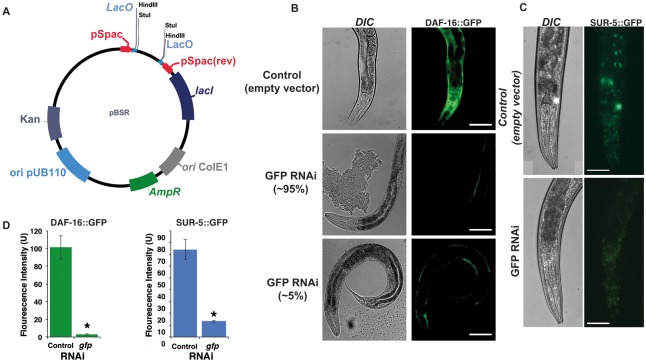
Genetic interference following ingestion of anti-GFP dsRNA-expressing B. subtilis by C. elegans.(A) Physical map of the pBSR vector. The DNA sequence corresponding to dsRNA of interest was cloned between flanking copies of the Pspac promoter to replace the spacer. B. subtilis strain BG322 was used as a host. GFP-expressing C. elegans strains TJ356 (B) and SD1084 (C) were fed on BG322 strains transformed with original pBSR vector and on bacteria expressing dsRNA corresponding to the gfp coding region. Under these conditions, 95% of the animals showed dramatic decrease in GFP expression after 24 hours of feeding. DAF-16::GFP and SUR-5::GFP expression is significantly decreased in the GFP (RNAi) treated animals. RNAi was induced starting at L4 larvae stage by feeding worms B. subtilis bacteria expressing dsRNA against GFP. GFP expression was measured at day 2 of adulthood. The y-axis denotes GFP expression (arbitrary units). Average expression and Standard Error from 20 animals are shown. *-p-value < 0.001 (t-test p-values). Scale bar = 100 μm.